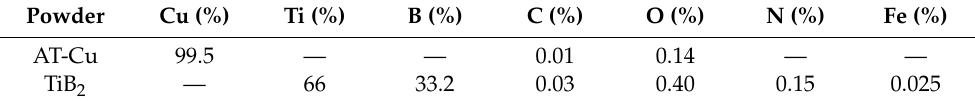
Figure 1. SEM micrographs of ( a ) water atomized Cu powder (AT ‐ Cu) and ( b ) blend of TiB 2 .